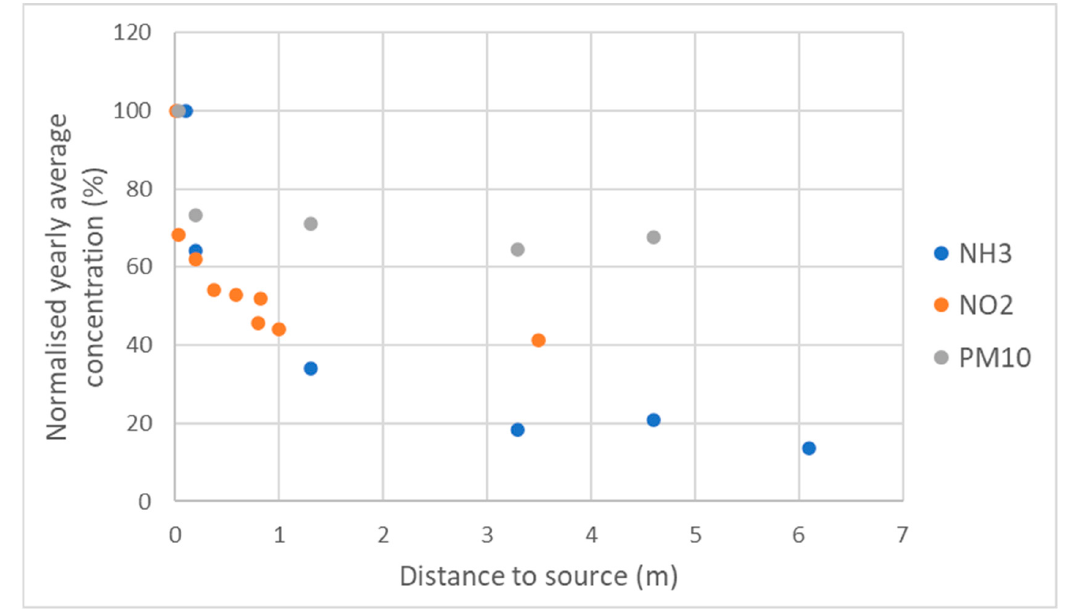
Figure 10. Relative decrease in concentration with increasing distance from the source based on a selection of representative locations of stables (PM 10 and NH 3 ) and traffic (NO 2 ). The concentration at distance 0 m is set to 100%.